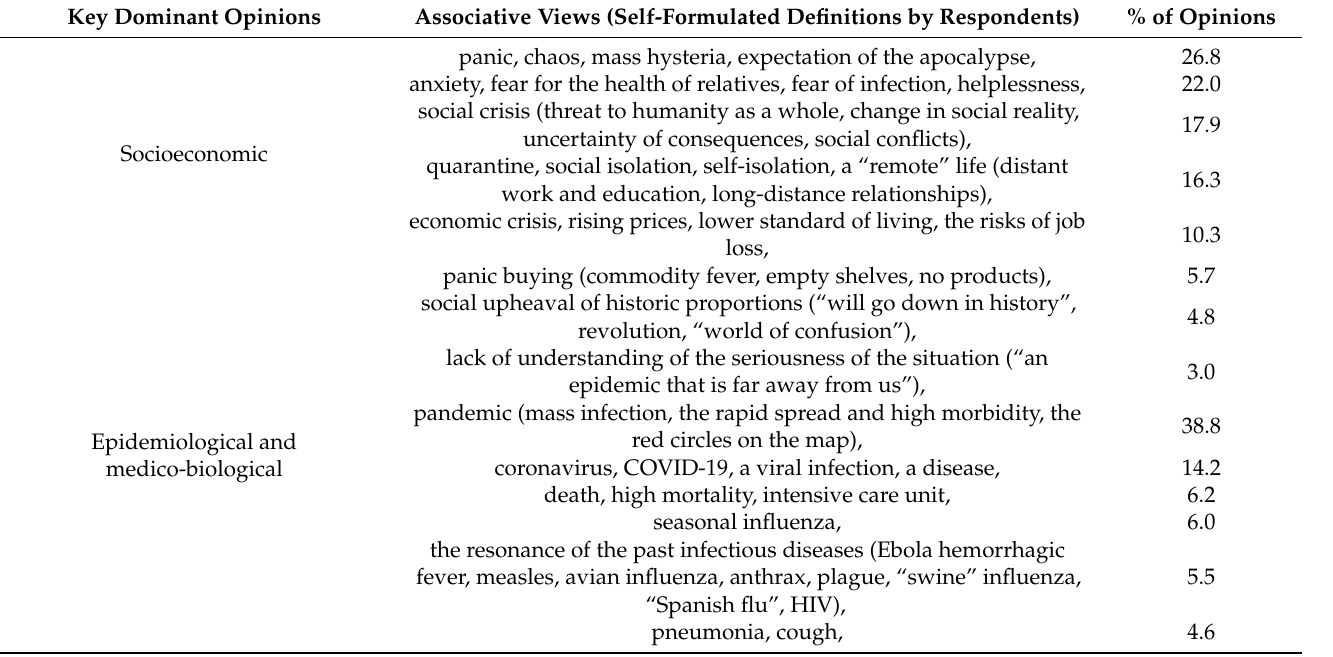
Table 1. Key dominant views of Muscovites about the coronavirus pandemic (n = 436, the sum is not equal to 100% due to the open format of the question and multiple